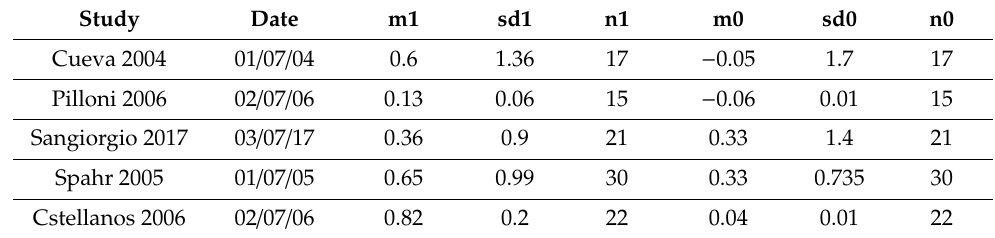
Table A3. Stata 15 IC Grid for